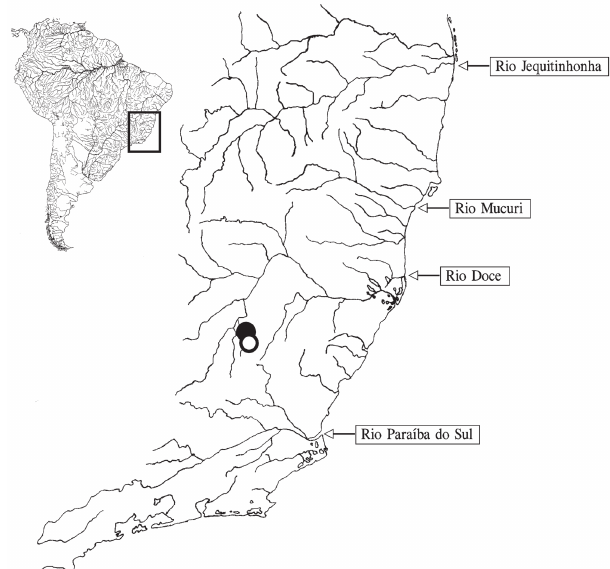
Fig. 2. Map of eastern Brazil showing geographic distribution of Pareiorhaphis nasuta . Open symbol represents type-locality. Comparative material examined : All from Brazil (in addition to that listed in Pereira & Reis, 2002) is: Hemipsilichthys nimius : MCP 33049, 105.1 mm SL (holotype), rio Carrasquinho below